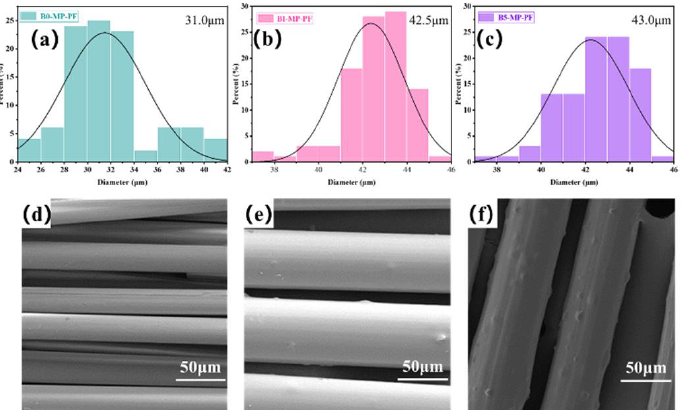
Figure 1. Fiber diameter distributions and SEM images of B0−MP−PF ( a , d ), B1−MP−PF ( b , e ) and B5−MP−PF ( c , f ).